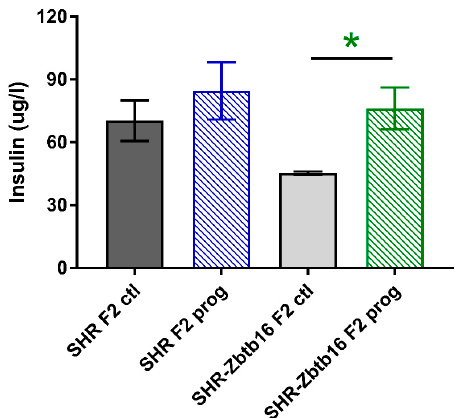
Figure 8. Fasting insulin concentrations in adult SHR F2 control male o ff spring (dark grey bars), SHR-Zbtb16 F2 control male o ff spring (light grey bars), F2-programmed SHR male o ff spring (blue patterned bars), F2-programmed SHR-Zbtb16 male o ff spring (green patterned bars) in 6 months of age. The strain comparison using the post-hoc Fisher’s least significant di ff erence test of the two-way ANOVA for STRAIN and PROGRAM as major factors are indicated as follows: * p < 0.05. E ff ect of programming in SHR-Zbtb16 strain is represented by green asterisks (*).